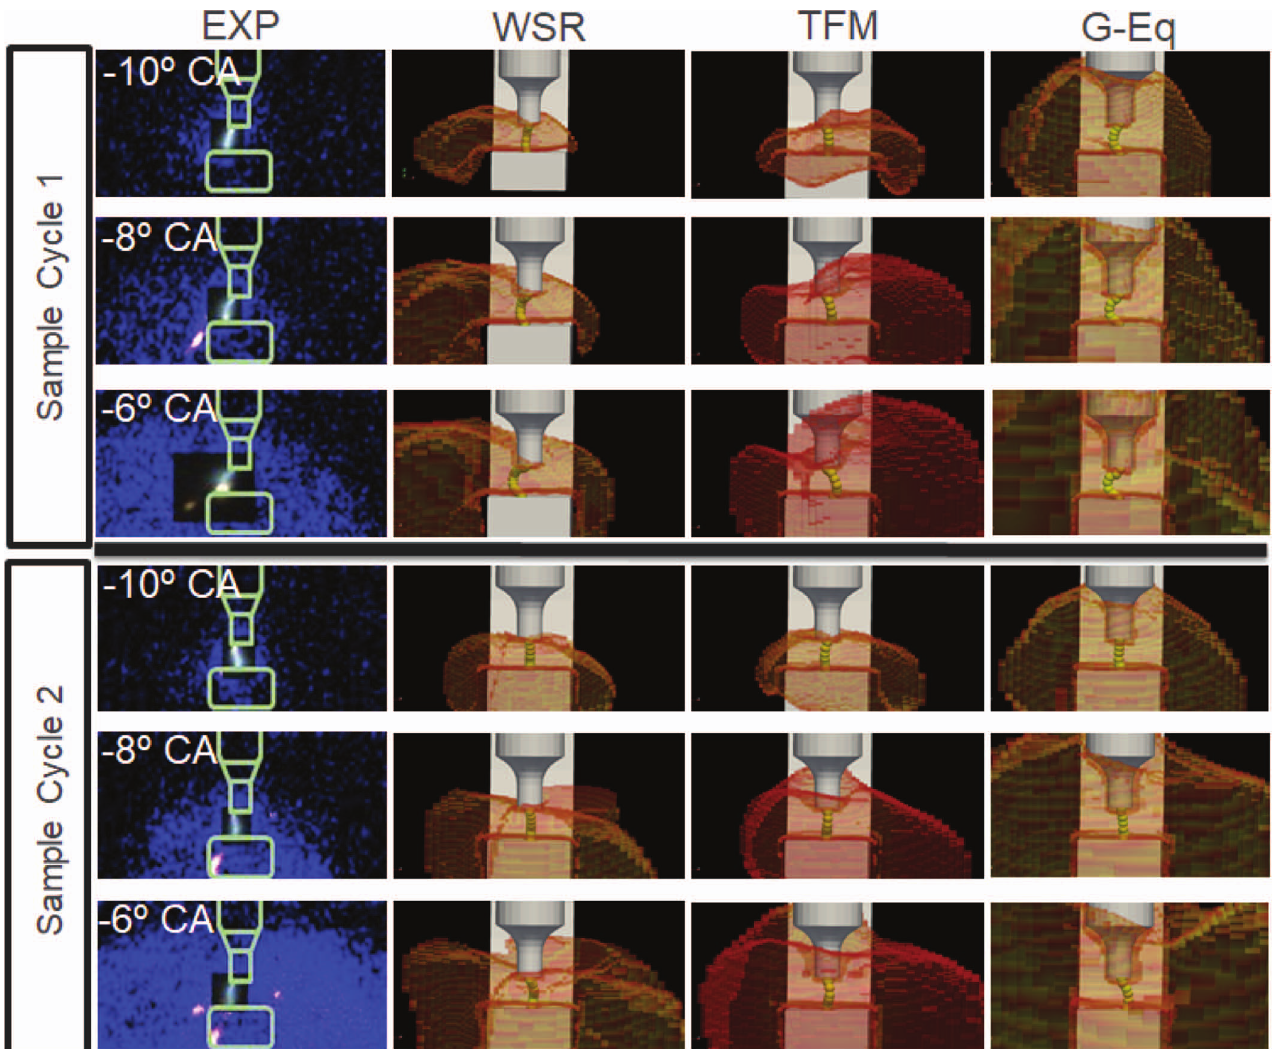
Fig. 17. Spark channel (or arc) and fl ame propagation for the three combustion models (WSR, TFM, and g -eq) and LESI compared to experimental images for two representative cycles at three different times during which ignition is active. The fl ame surface is represented by the T = 1500 K iso-surface and the arc is represented by a yellow line as predicted by the LESI